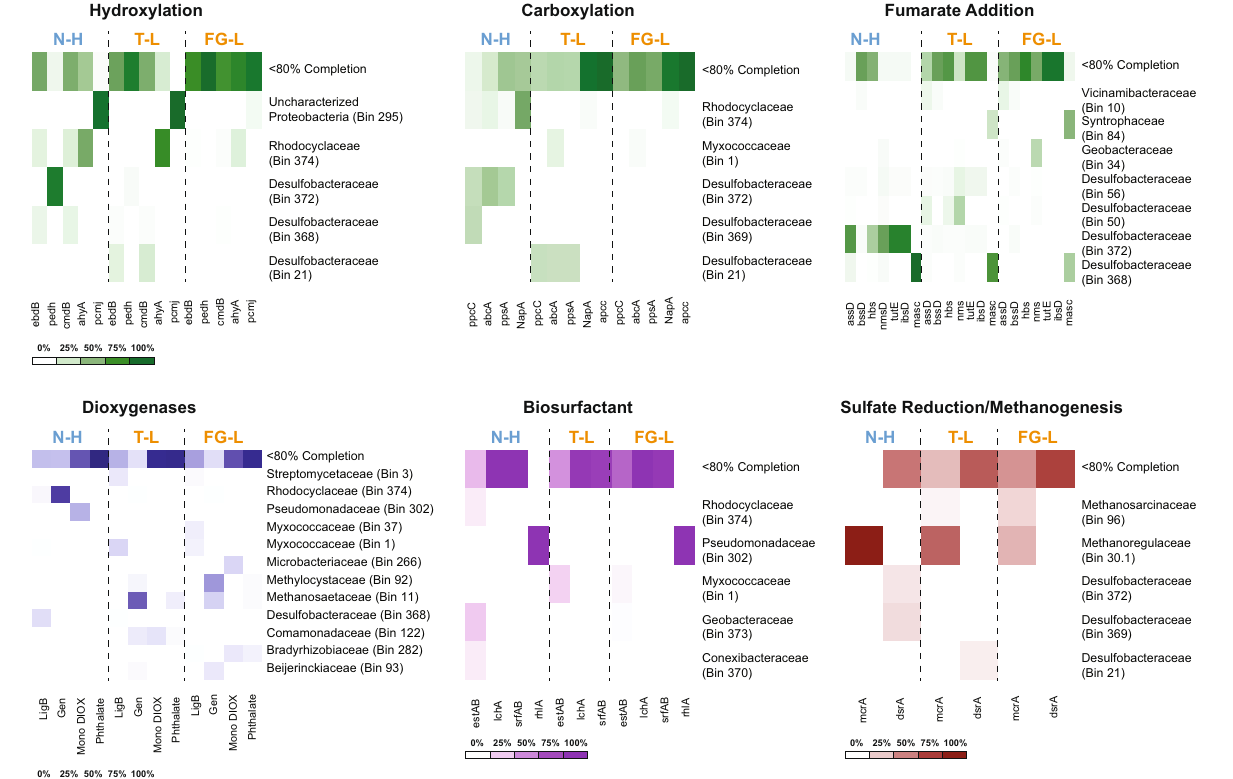
Fig. 3 Comparison of gene abundances across metagenome-assembled genomes MAGs. Heatmaps from all MAGs from shotgun metagenomic samples depicting the relative gene abundance for individual genes involved in hydrocarbon degradation for the high-sulfate coal seam (N-H) and two low-sulfate coal seams (T-L and FG-L). Only high-quality MAGs (>80% completion) were taxonomically classi fi ed. All MAGS below 80% completion were grouped together as <80% Completion. The six different heatmaps, displaying the genes of interest, were grouped based on method of anaerobic degradation (green heatmaps) via hydroxylation, carboxylation, and fumarate addition, aerobic degradation (blue heatmap) via dioxygenases, biosurfactant production (purple heatmap), and sulfate reduction/ methanogenesis (red heatmap). All relative abundance of each gene found in the corresponding MAGs are represented by a color gradient (as seen in legend below heatmap) with the darkest color indicating the highest relative abundance for each sample and white indicating lack of the